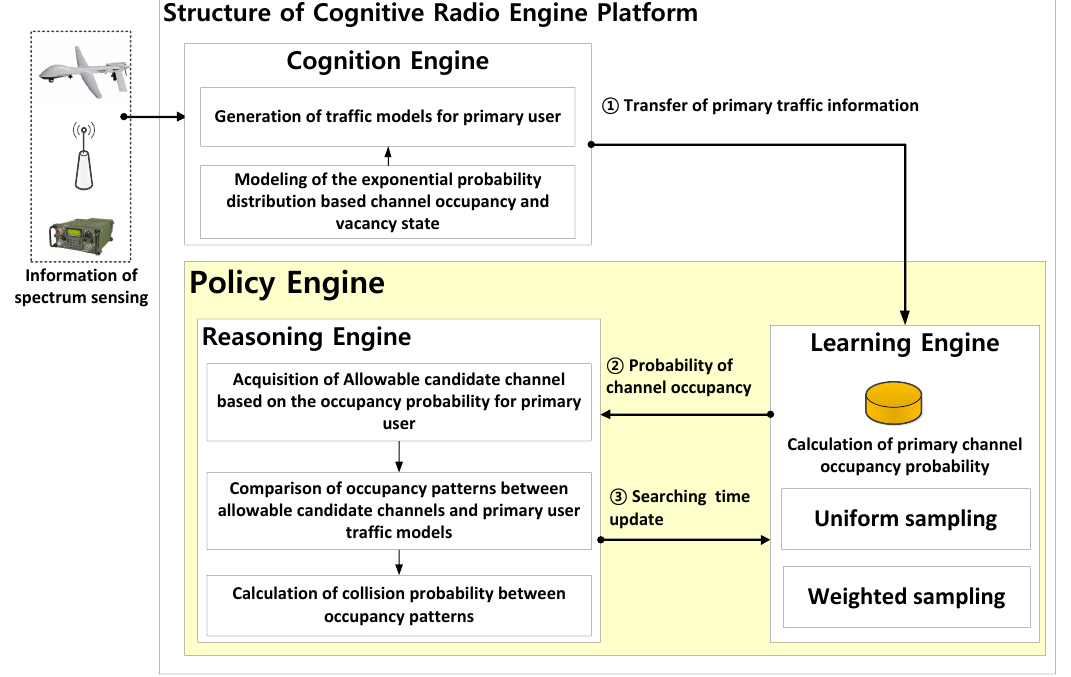
Figure 3. Proposed cognitive radio engine